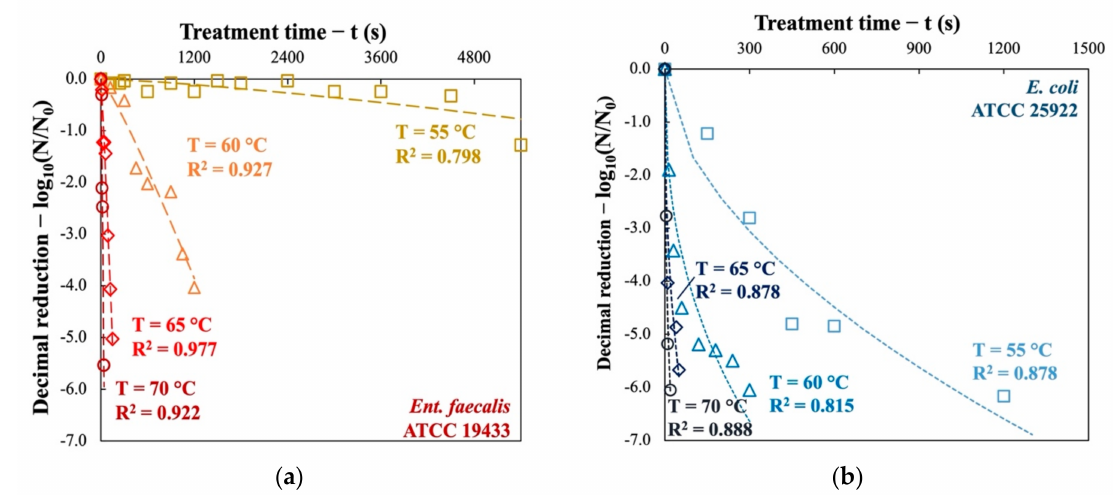
Figure 1. Inactivation kinetics of ( a ) Ent. faecalis and ( b ) E. coli subjected to thermal pasteurization at four temperatures in nutrient